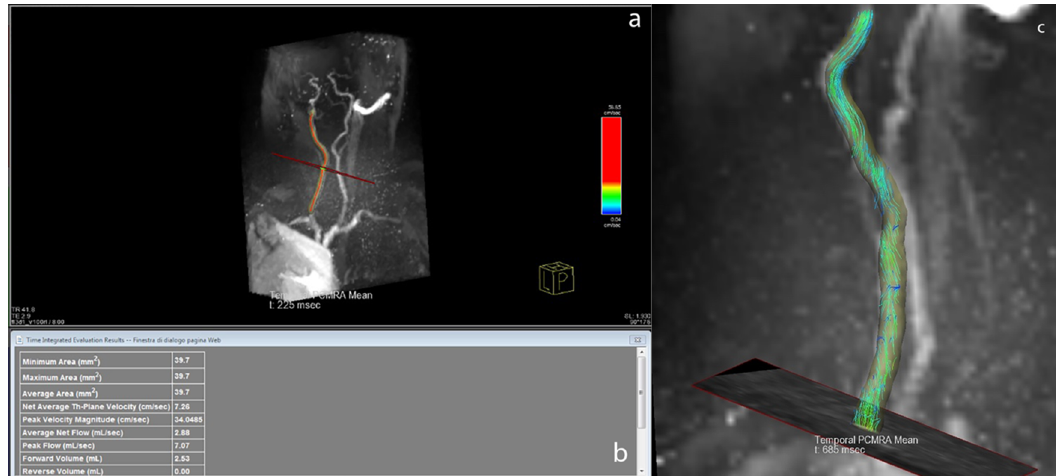
Figure 2. Reconstruction of a carotid artery using 4D-flow software; ( a ) plane of interest is highlighted; ( b ) table with flow data from the plane shown in a; and ( c ) single frame from streamlines of common carotid artery and internal carotid artery.